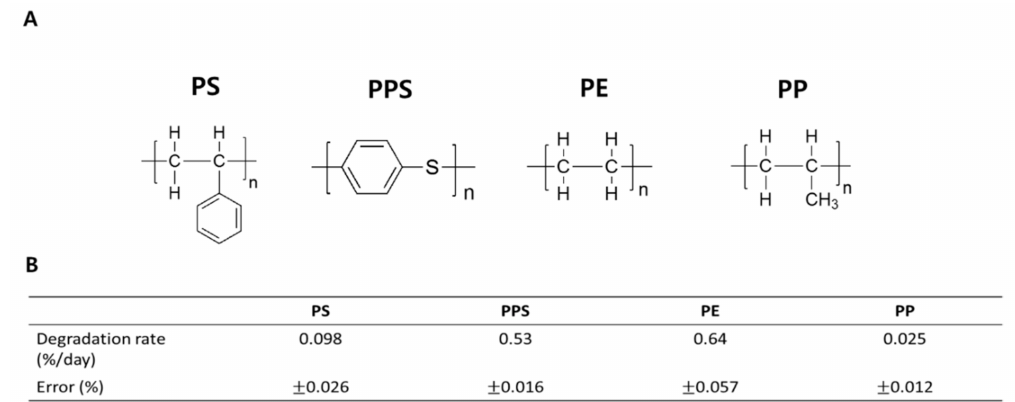
Figure 4. Comparison of biodegradation rate of PS, PPS, PE and PP by P. aeruginosa . ( A ) Chemical structures of the four di ff erent types of plastic. ( B ) Biodegradation rates for all plastics. Biodegradation